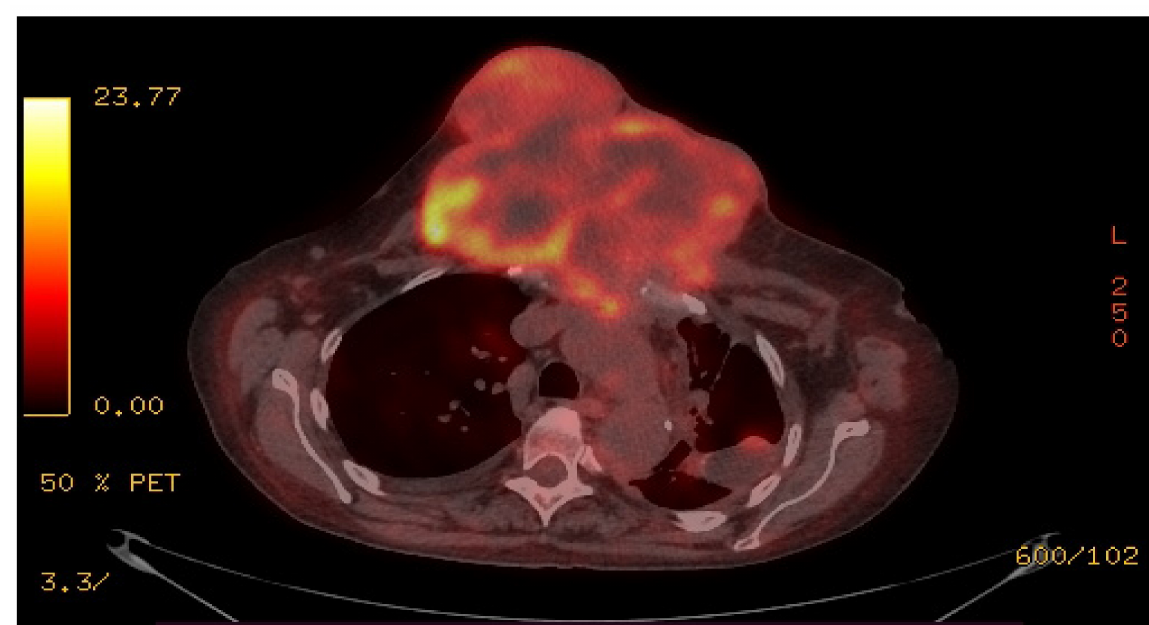
Figure 3. PET-CT